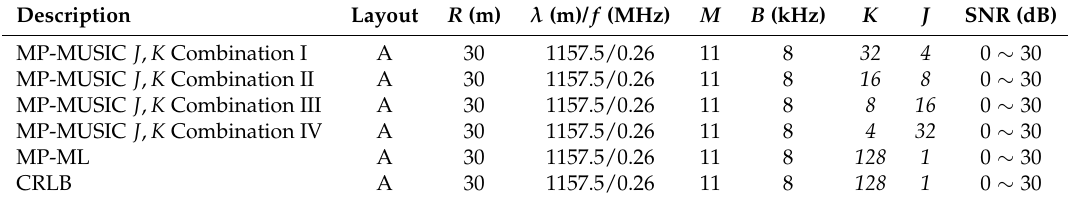
Table 4. Parameter setting in MP-MUSIC with different J , K combinations.